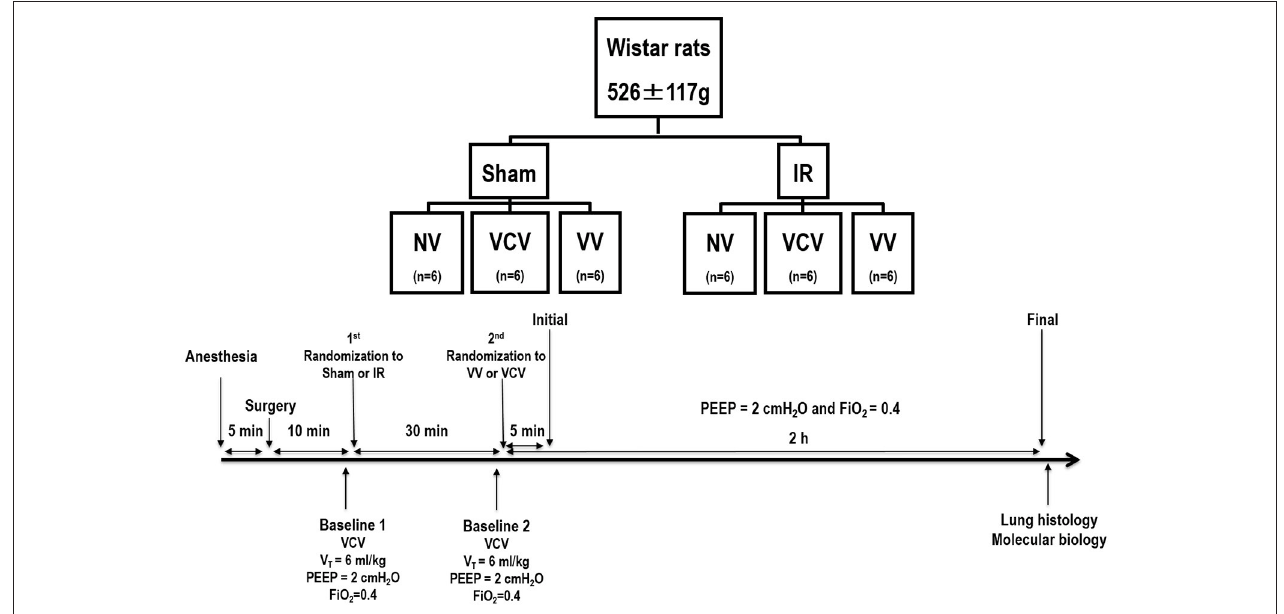
FIGURE 1 | Timeline representation of the experimental protocol. Baseline 1: evaluation of baseline lung health; Baseline 2: evaluation of lung damage induced by left pulmonary hilum clamping (ischemia-reperfusion) compared to sham surgery. Initial: Immediately after randomization to variable controlled ventilation (VV) or volume controlled ventilation (VCV). NV: non-ventilated animals. V T : tidal volume; PEEP: positive-end expiratory pressure. FiO 2 : fraction of inspired oxygen. Gas exchange and lung mechanics were evaluated at Baseline 1, Baseline 2, Initial, and